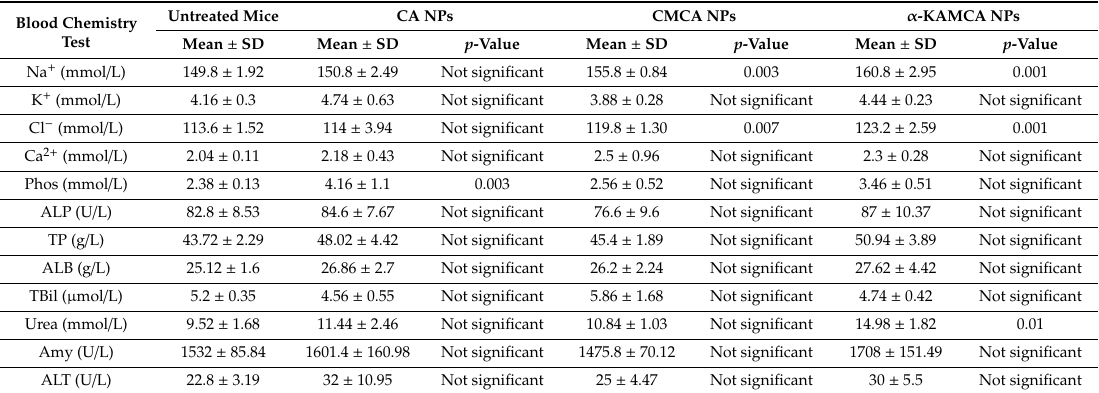
Table 4. Acute toxicity study in mice treated with CA, CMCA, and α -KAMCA NPs ( n = 5). Phos—phosphate; ALP—alkaline phosphatase; TP—total protein; ALB—albumin; TBil—total bilirubin;